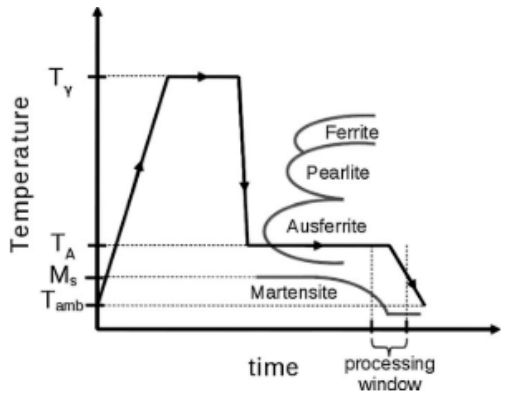
Figure 1. Phase transformations and variables of a conventional austempering heat treatment (Reprinted with permission from ref. [30]. 2015 Springer Nature).